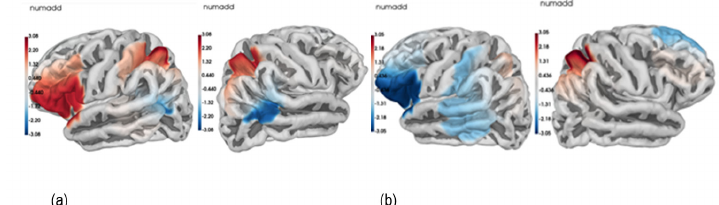
Figure 3. Activation associated with a numerical format of calculation task in (a) group with high level of math competencies, and (b) group with low level of math